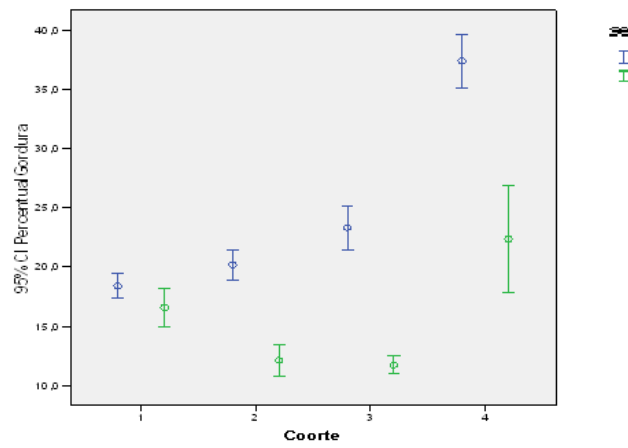
Figura 2. Ilustrativo para a percentual de